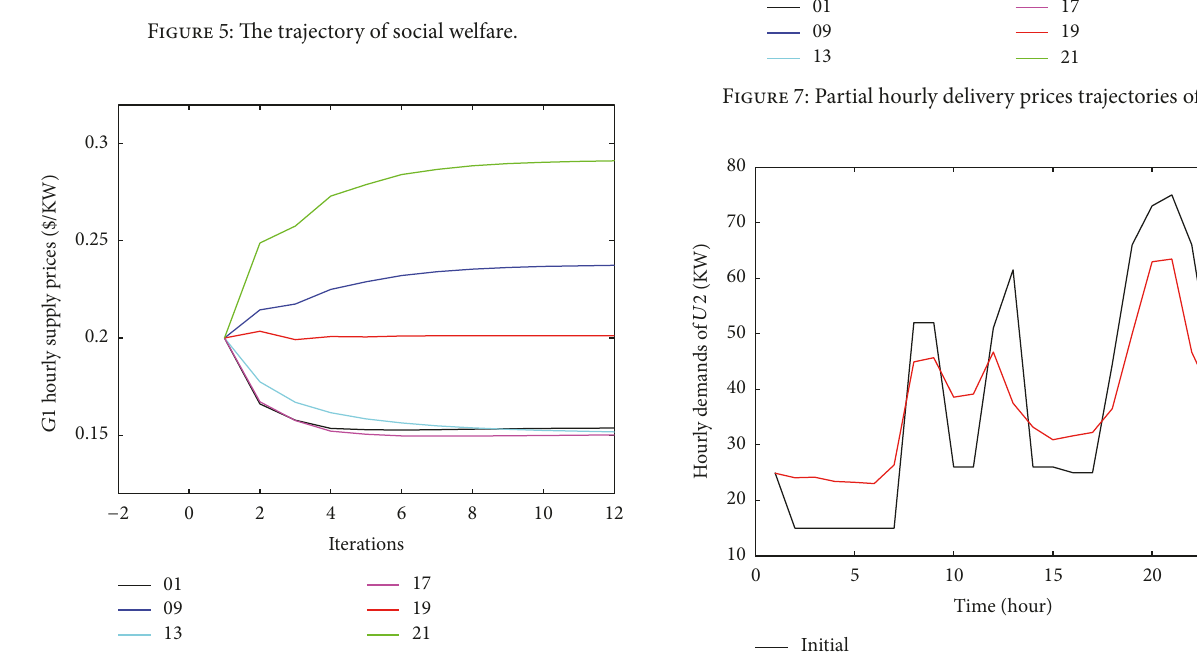
Figure 6: Partial hourly supply prices trajectories of G 1.